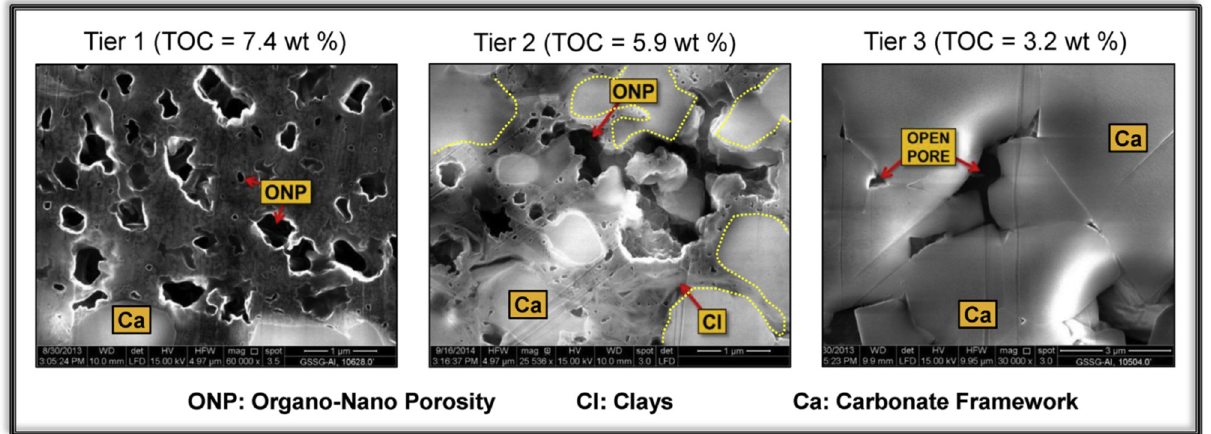
Figure 2. Typical TOC and micro-pore structure in the three benches or tiers of the TWQ target formation, according to Hakami et al. [17,18].